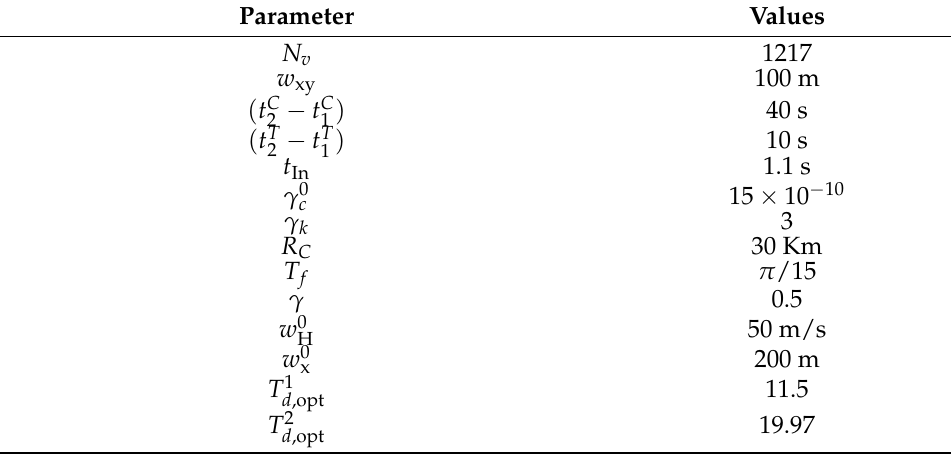
Figure 4. ( a ) Simulation for T 1 Table 1. Parameters of the proposed